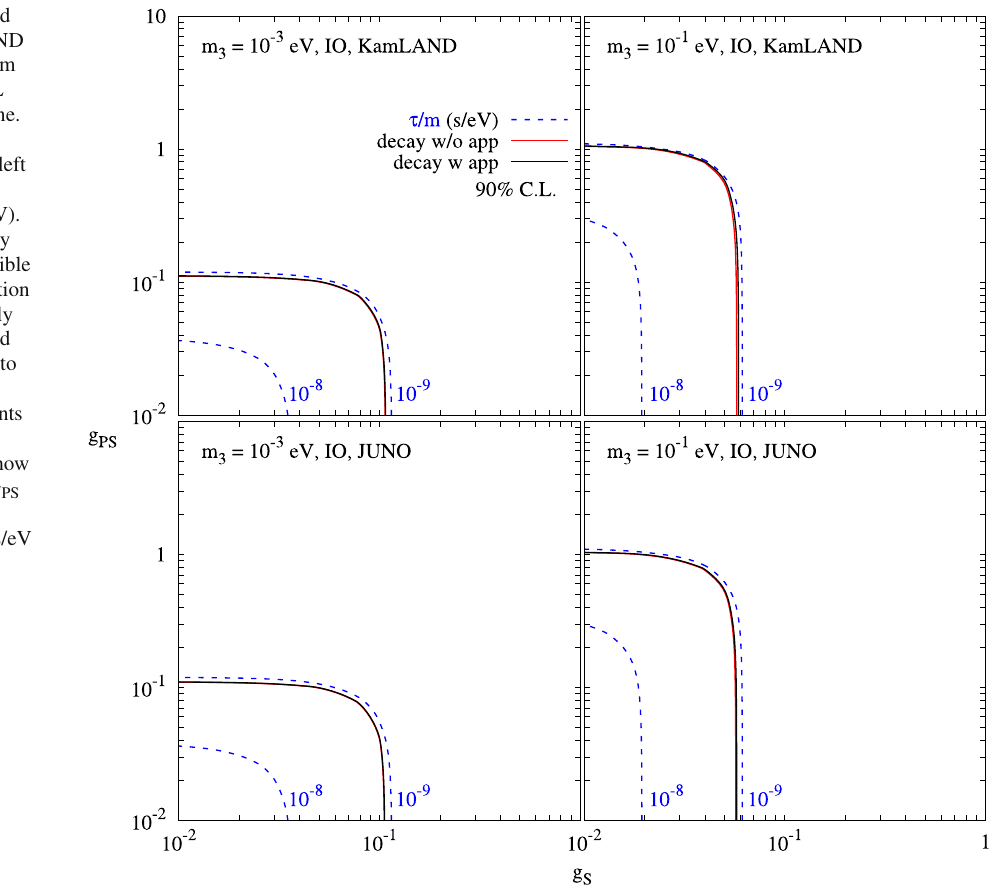
Fig. 4 Decay constraints and sensitivity plots for KamLAND (top panel) and JUNO (bottom panel). We show the 90% CL contours in the g S − g PS plane. The true mass ordering is assumed to be inverted. The left (right) panel is for m lightest = 10 − 3 eV (10 − 1 eV). The red curve (labeled “decay w/o app”) corresponds to visible decay including the contribution from the parent neutrinos only while the black curve (labeled “decay w app”) corresponds to visible decay including the contributions from both parents as well as the daughter neutrinos. The blue curves show the respective values of g S , g PS which give (τ/ m ) = 10 − 8 , 10 − 9 heaviest